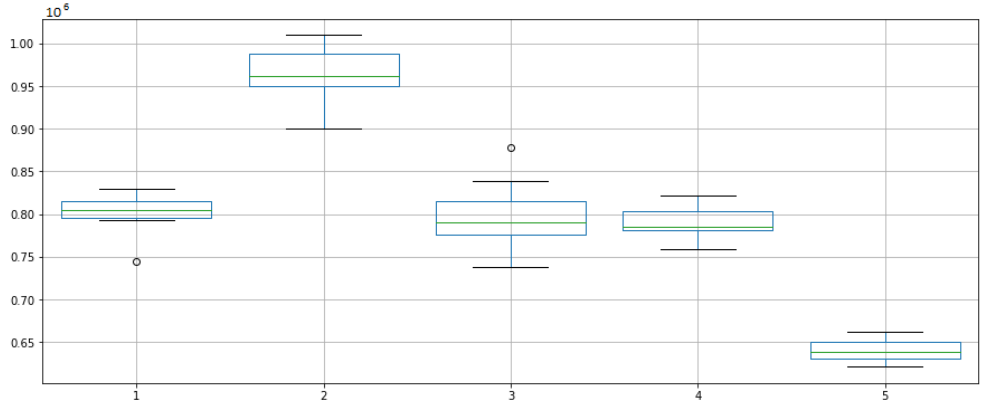
Figure 21. Boxplot of scenarios on the Hungarian